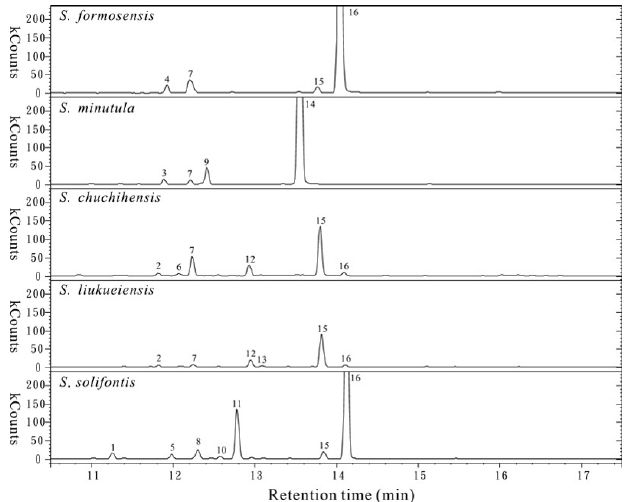
Fig 4. Gas chromatograms of venom revealing 16 different com- pounds across the five Strumigenys species.